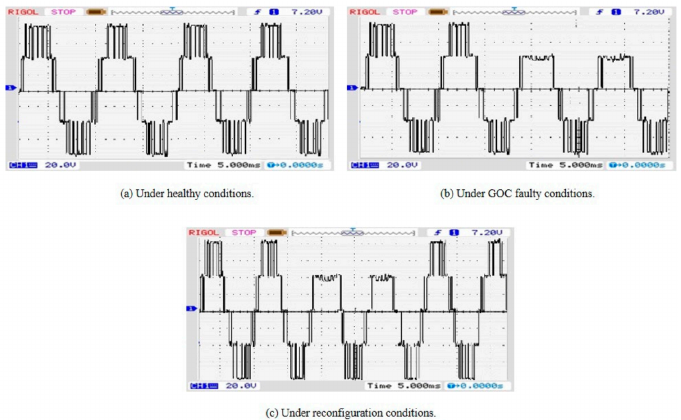
Figure 11. 5-Level output voltage under healthy, GOC faulty and reconfiguration conditions.